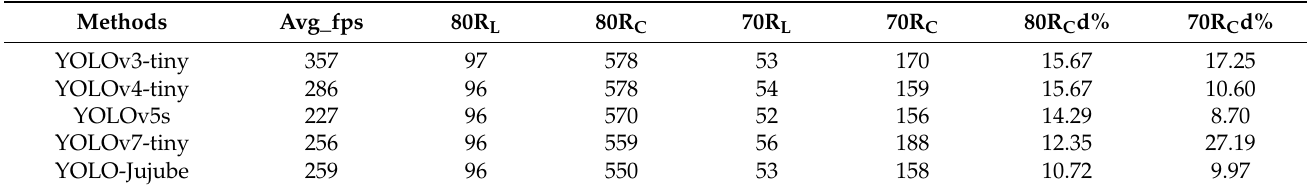
Table 5. Summary of sorting and counting on images in the test set.